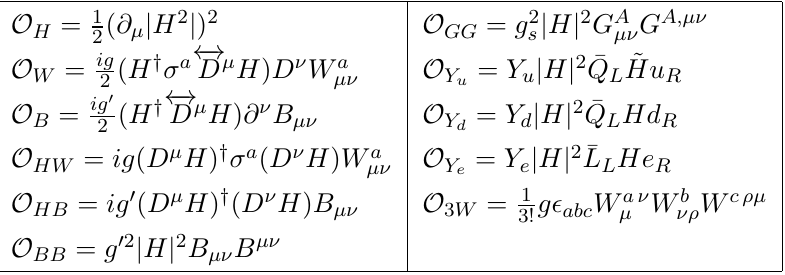
Table 6 . Operators in the SILH basis considered in our study. Assuming no corrections to elec- troweak precision observables, only one combination of O W and O B is left after imposing the electroweak precision constraints of c W + c B = 0. While Y are 3 (cid:2) 3 matrices in general, we u=d=e only consider the relevant diagonal ones y t , y c , y b , y (cid:28) and y (cid:22) . In this table, (cid:15) abc is the totally anti-symmetric tensor for SU(2).